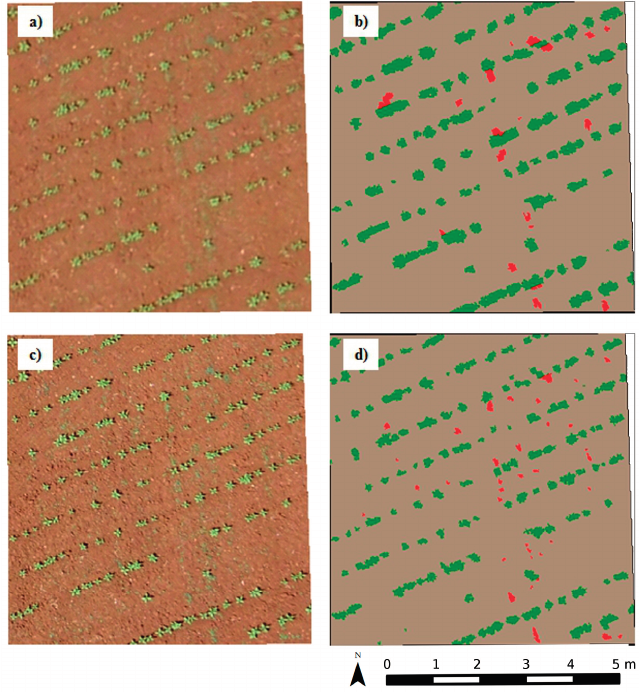
Figure 2. ( a ) Illustration of the UAV-image taken with the visible camera at 60 m; and ( b ) corresponding weed seedling map using object-based image analysis (OBIA) (green: crop rows, red: weed, grey: bare soil); ( c ) illustration of the RS-image at 60 m; and ( d ) corresponding weed seedling map using